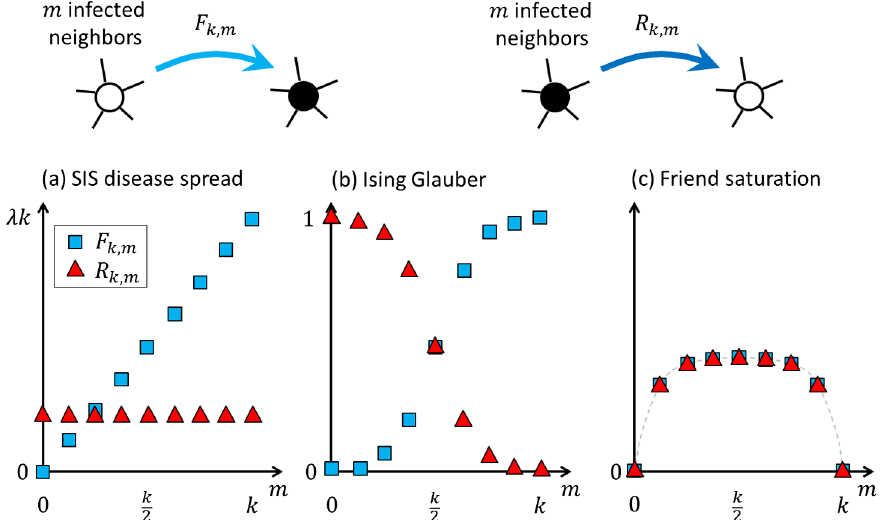
FIG. 1. Schematic of the infection rate F and recovery rate R as defined in the text. Here—and in Figs. 9 and 10—white nodes k;m k;m are susceptible or inactive or spin-down and black nodes are infected or active or spin-up. Examples of the dependence of the rates on the number m of infected neighbors include (a) the susceptible-infected-susceptible disease-spread model, (b) Glauber dynamics for the Ising model, and (c) a stylized ‘‘friend-saturation’’ model. Case (c) is motivated by the data analysis of social contagion for Digg stories in Fig. 4 of Ref. [17], where the probability of, for example, becoming infected (voting on a Digg story) initially increases with the number of infected neighbors but then saturates and eventually decreases, giving a function that is roughly symmetric about m ¼ k= 2